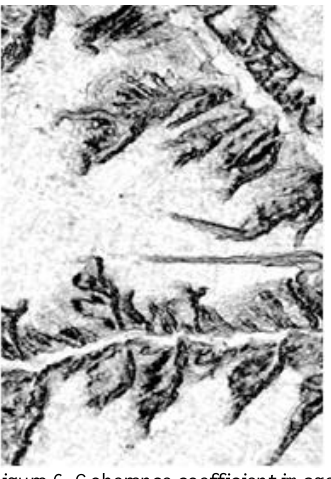
Figure 6. Coherence coefficient image